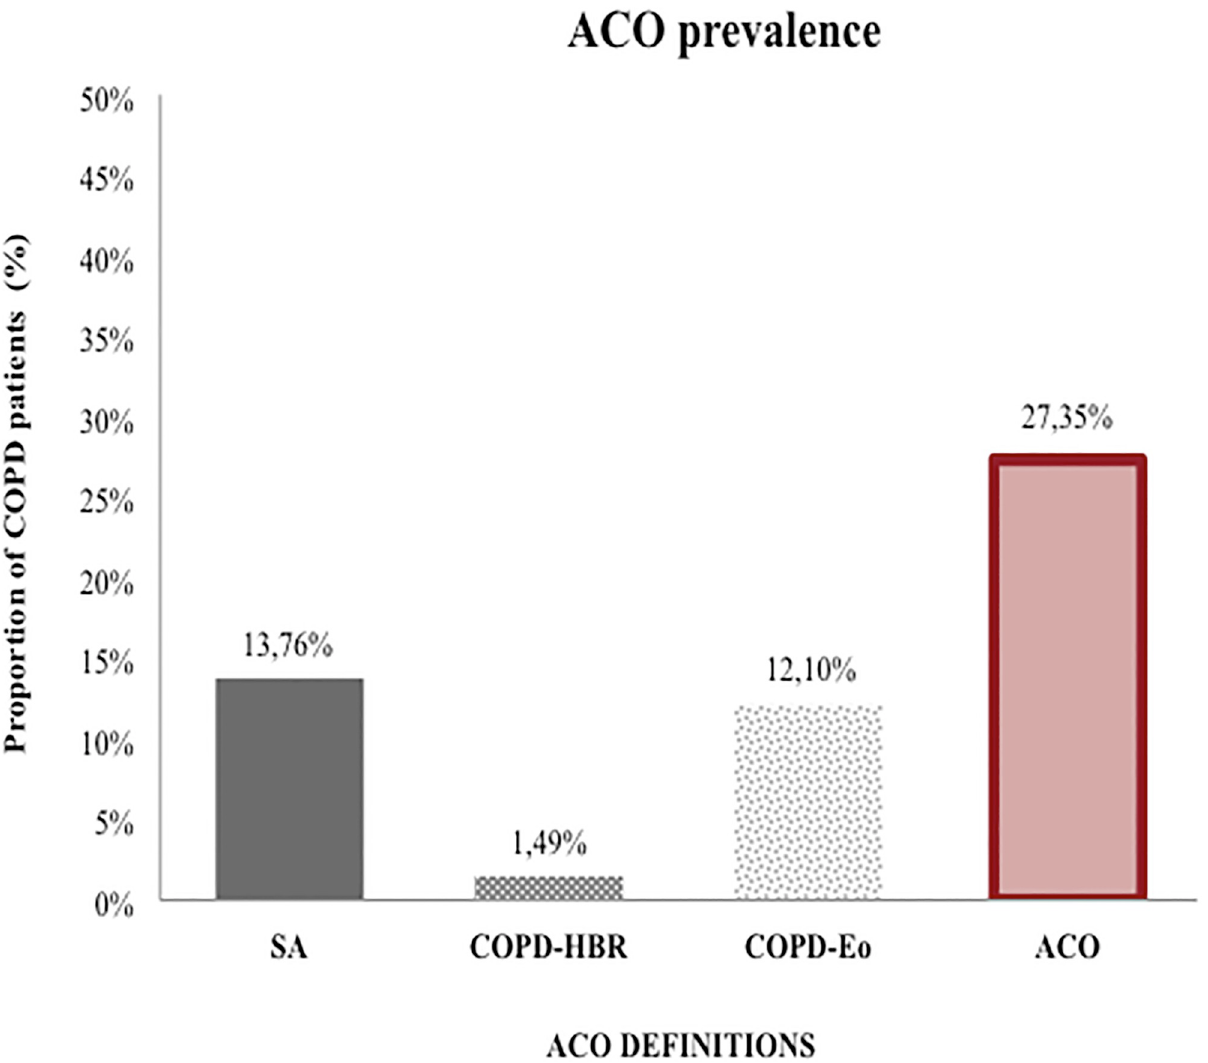
Fig 2. ACO prevalence. ACO: Asthma-COPD overlap; COPD: Chronic obstructive pulmonary disease; SA: smoking asthmatic; Eos: Eosinophil; HBR: High bronchodilator response.